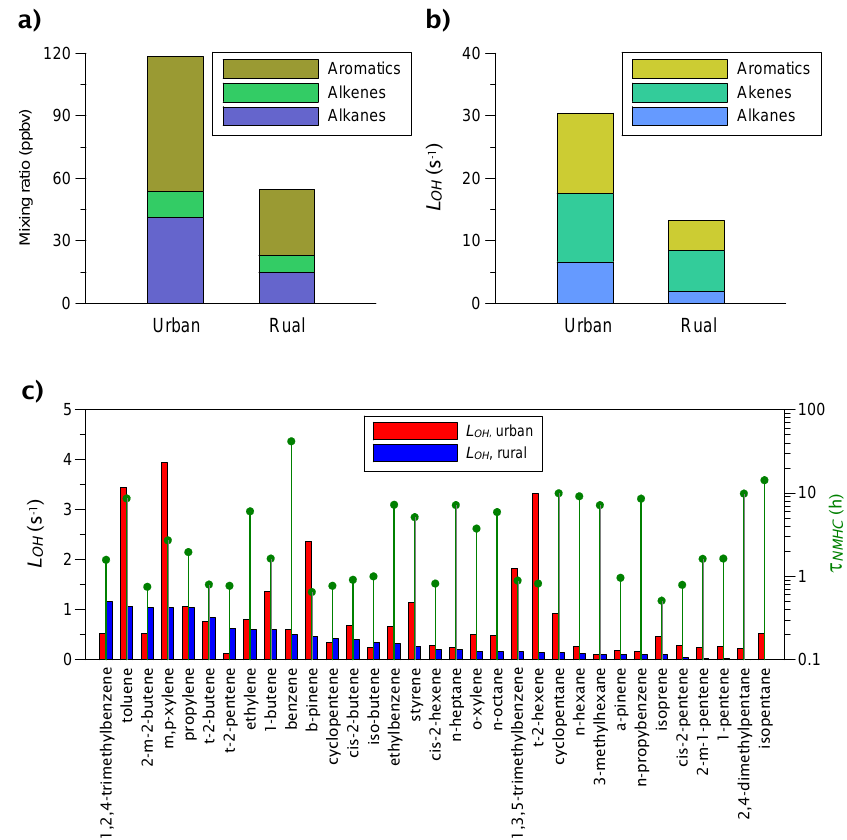
Fig. 8. Measured mixing ratios of (a) alkanes, alkenes and aromatics, (b) calculated reactivity, L OH , of alkanes, alkenes and aromatics, and (c) L OH and chemical lifetime, τ NMHC , of individual NMHC species at the Beigongda (urban) and Xin’an (rural) sites during IPAC-NC.